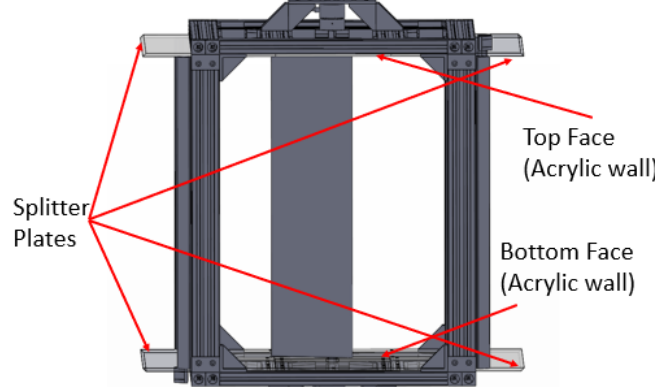
Figure 13. 2D test section: acrylic walls and splitter plates.